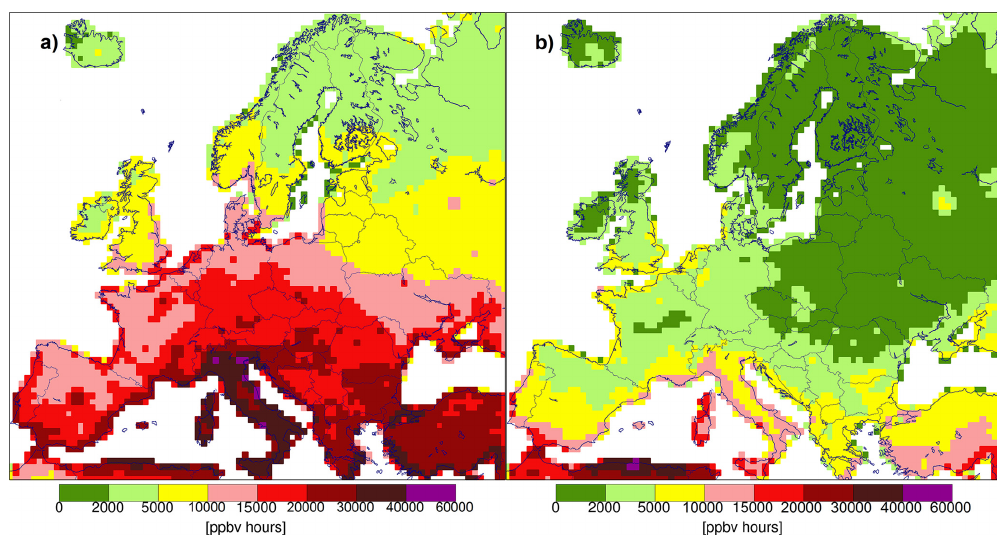
Figure 3. Present and future modelled AOT40 (ppb-hours) as 20-year averages (a) 1990–2009 and (b) 2040–2059 assuming O 3 precursor emission reductions according to the RCP4.5 scenario and climate change under the IPCC SRES A1B scenario. AOT40 was accumulated over daylight hours (global radiation >50Wm − 2 ) during the fixed April–September accumulation period mainly relevant for forest trees. Model results are based on O 3 concentrations from the lowest model layer ( ∼ 30m above ground).